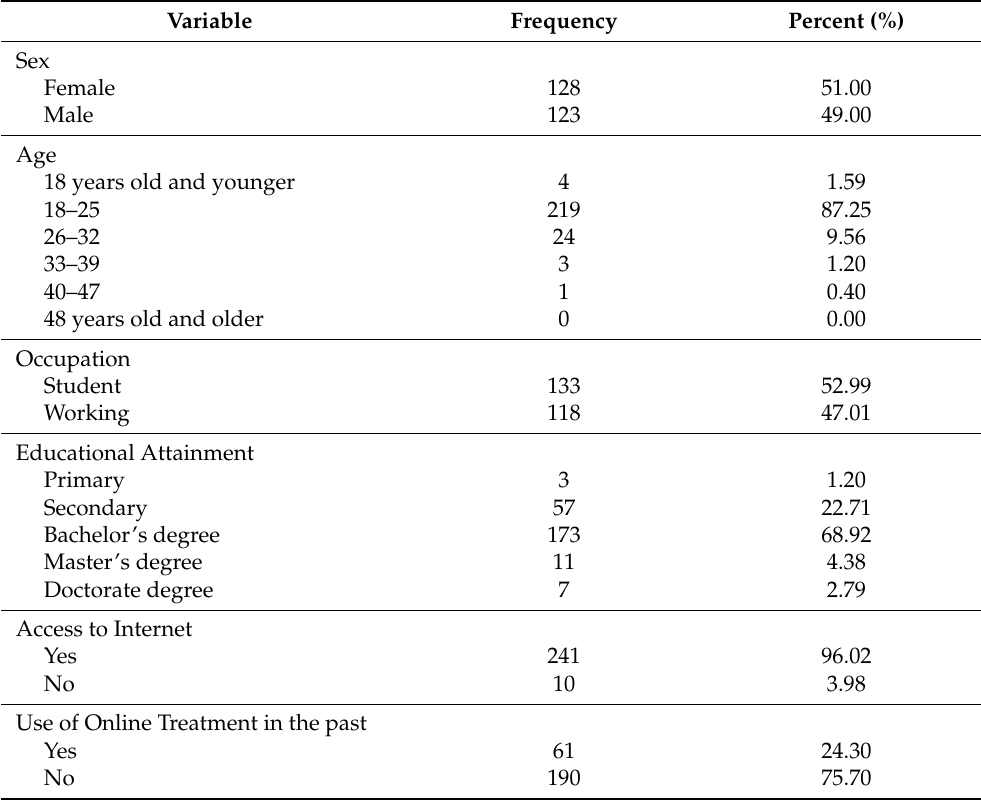
Table 1. Demographic information of the